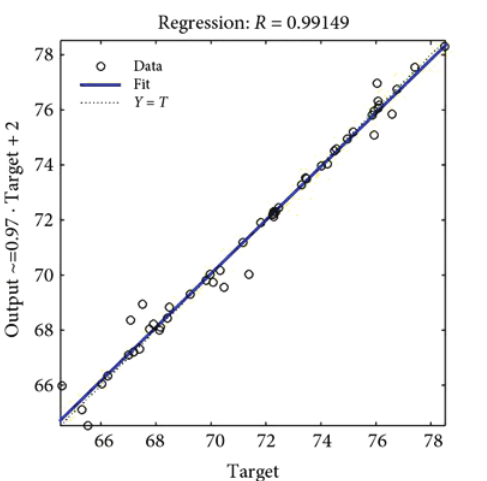
Figure 14. Correlation coefficient of neural network model